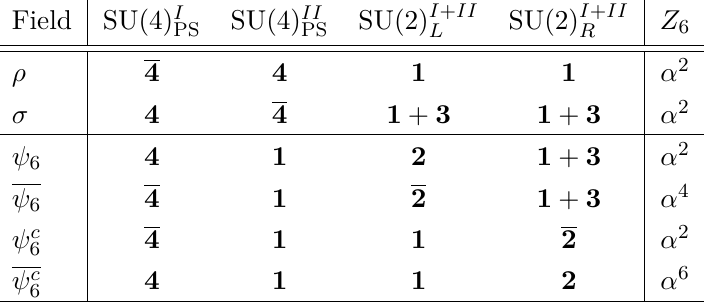
Table 5 . The extra fields in table 4 decompose under G 4422 as shown.